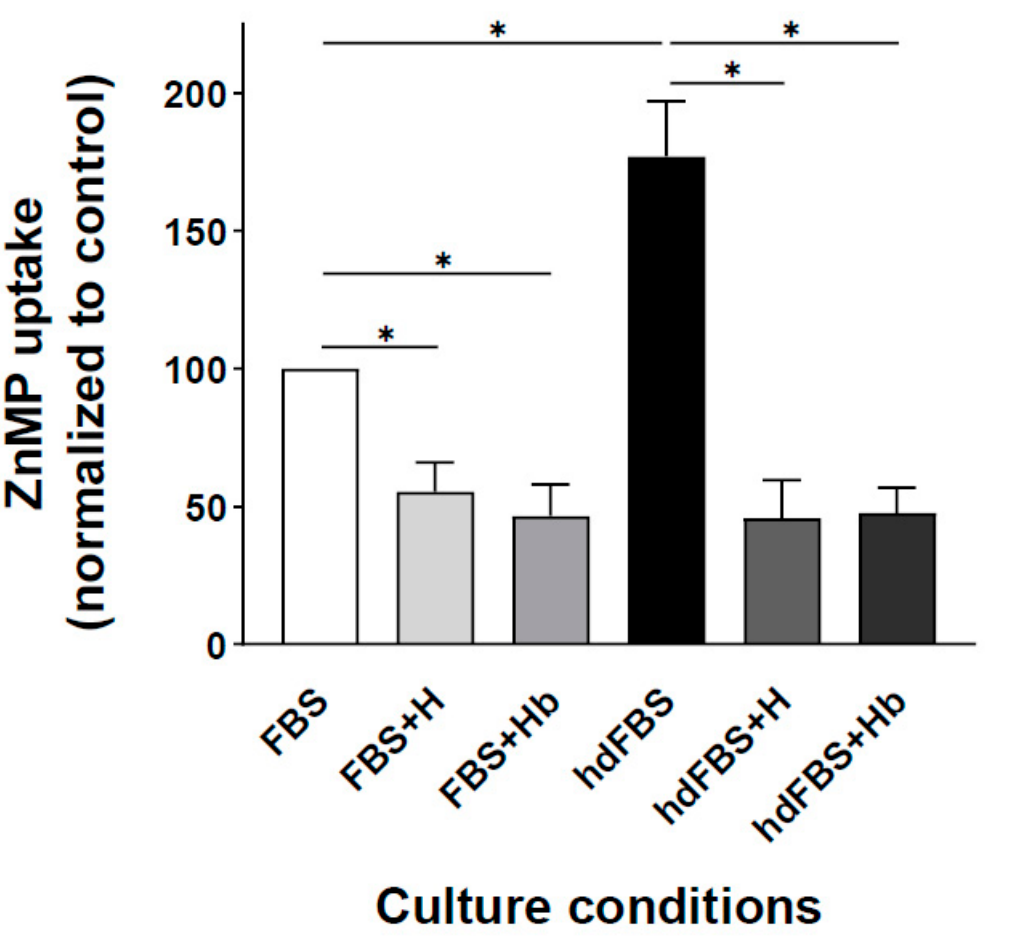
Figure 3. Heme deprivation induces ZnMP uptake in L. major promastigotes. Log-phase L. major promastigotes were grown in culture medium containing 10% FBS (fetal bovine serum) or 20% hdFBS (heme-depleted FBS) supplemented or not with 10 µ M heme (H) or 2.5 µ M hemoglobin (Hb). Net ZnMP uptake was then measured as described in Materials and Methods. Data represented as percentage uptake found after culturing the parasites in FBS-supplemented medium. Experiments were performed three times in duplicate, and data expressed as mean ± SEM. * p ≤ 0.05 was considered statistically